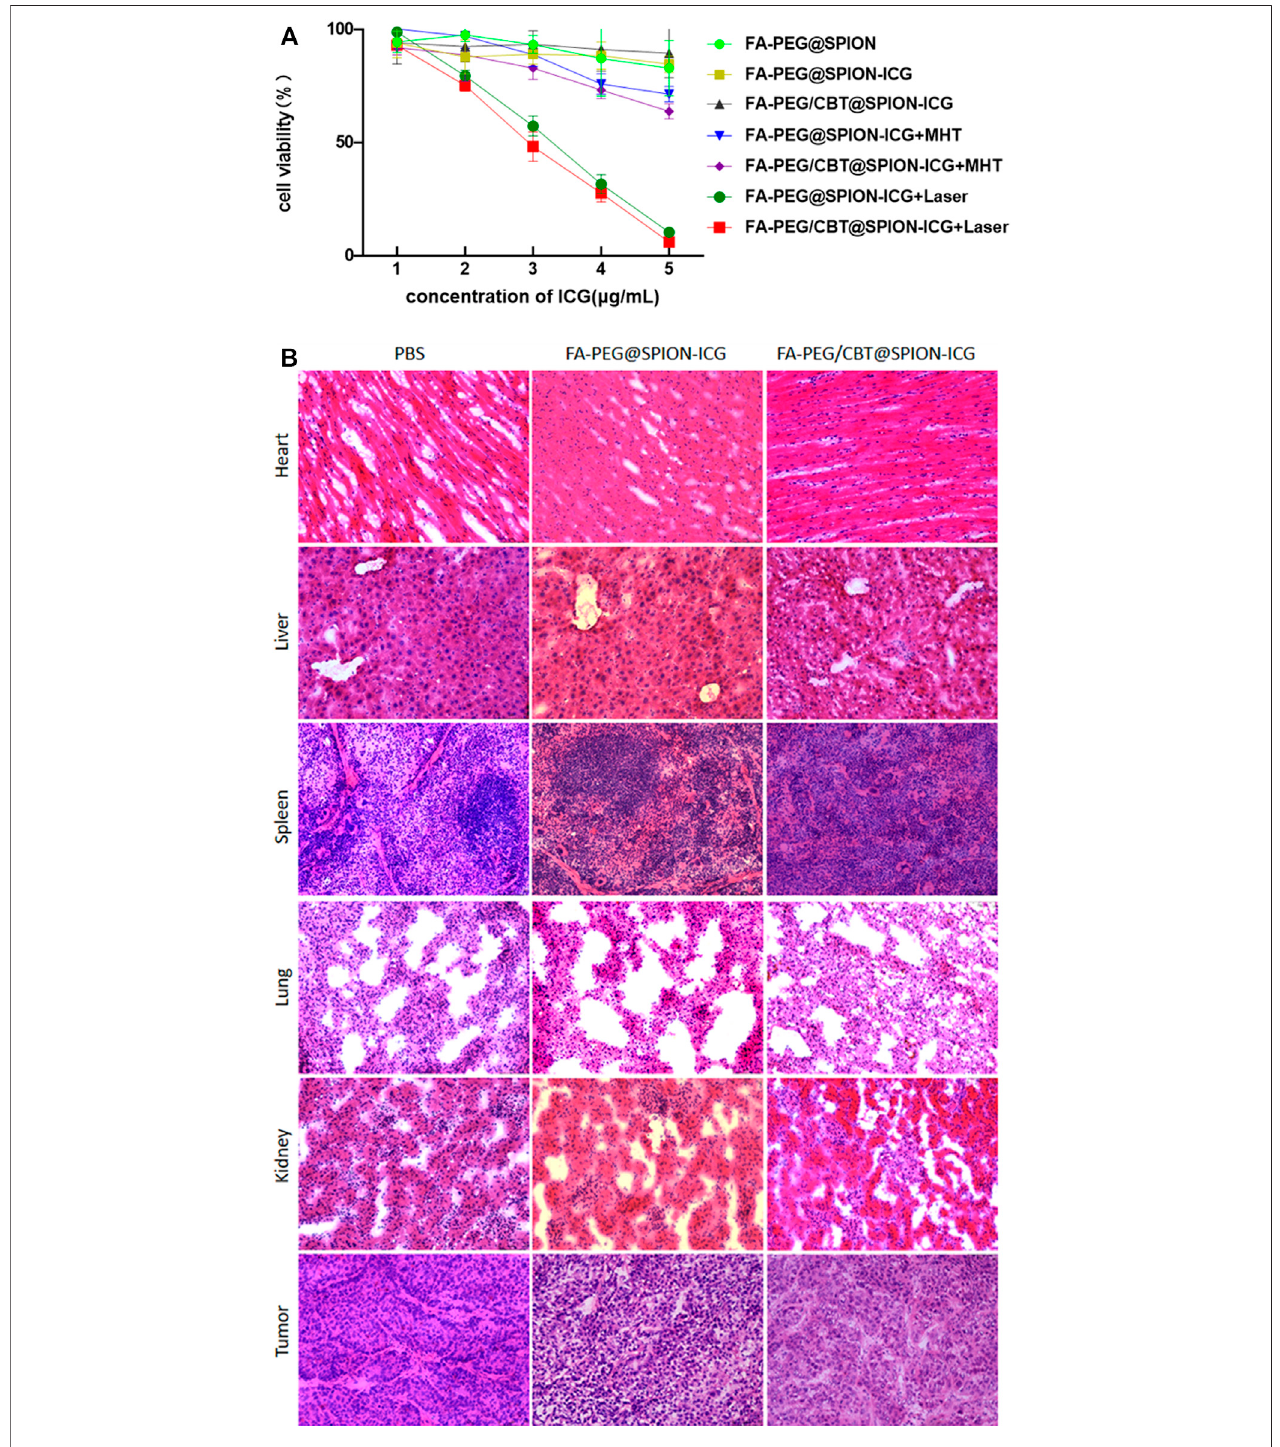
FIGURE 6 | Cell viability detected by CCK-8 assay (A) . H&E staining of the heart, liver, spleen, lung, kidney, and tumor tissues of nude mice ( × 20) (B) .